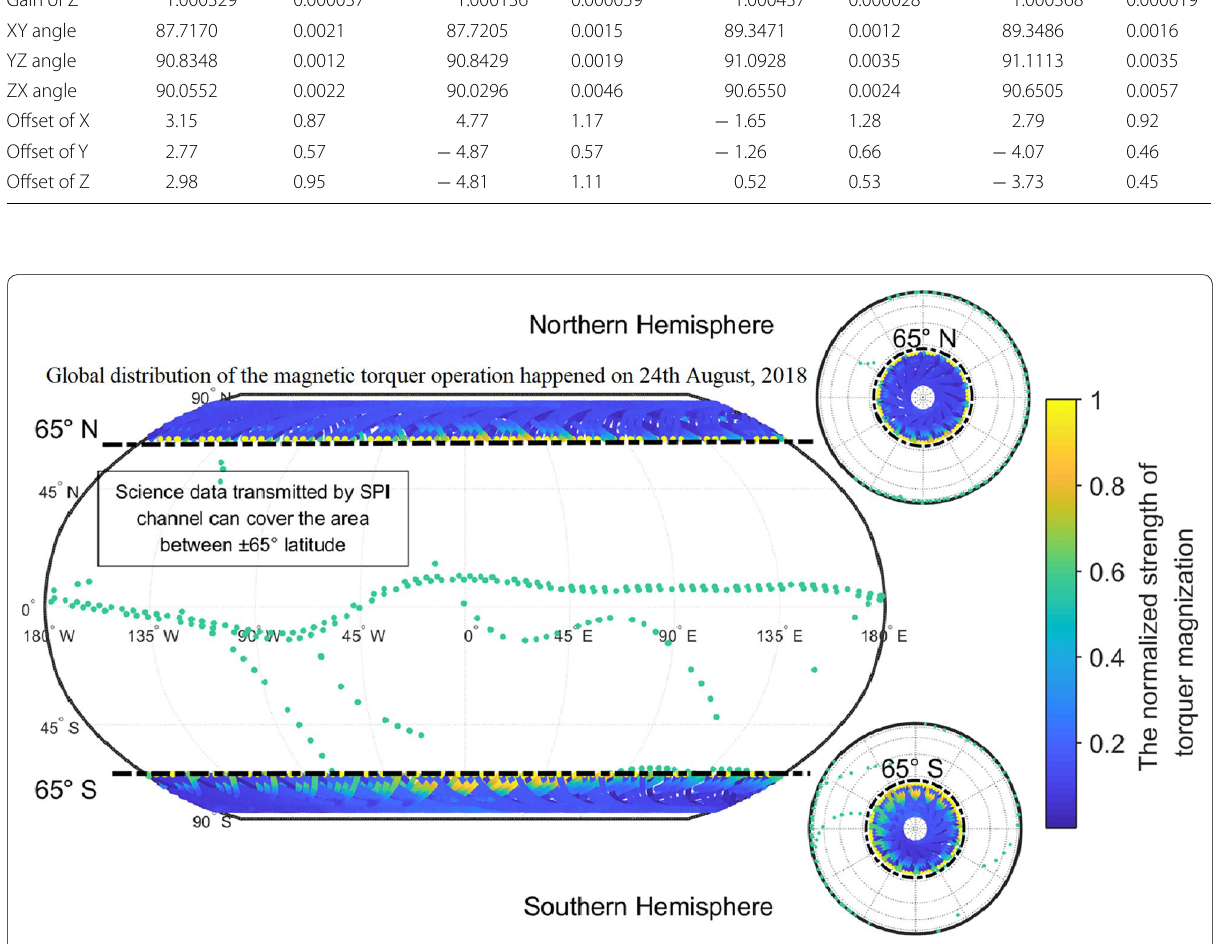
Fig. 14 Global distribution of the magnetic torquer operation on 24th August 2018. When any component of the geomagnetic field becomes zero, the magnetic torquer will magnetize its inner core for 2